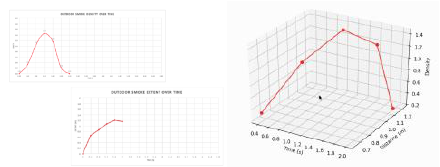
Figure 8. Example of the Generated Graphs in 2D (left) and 3D